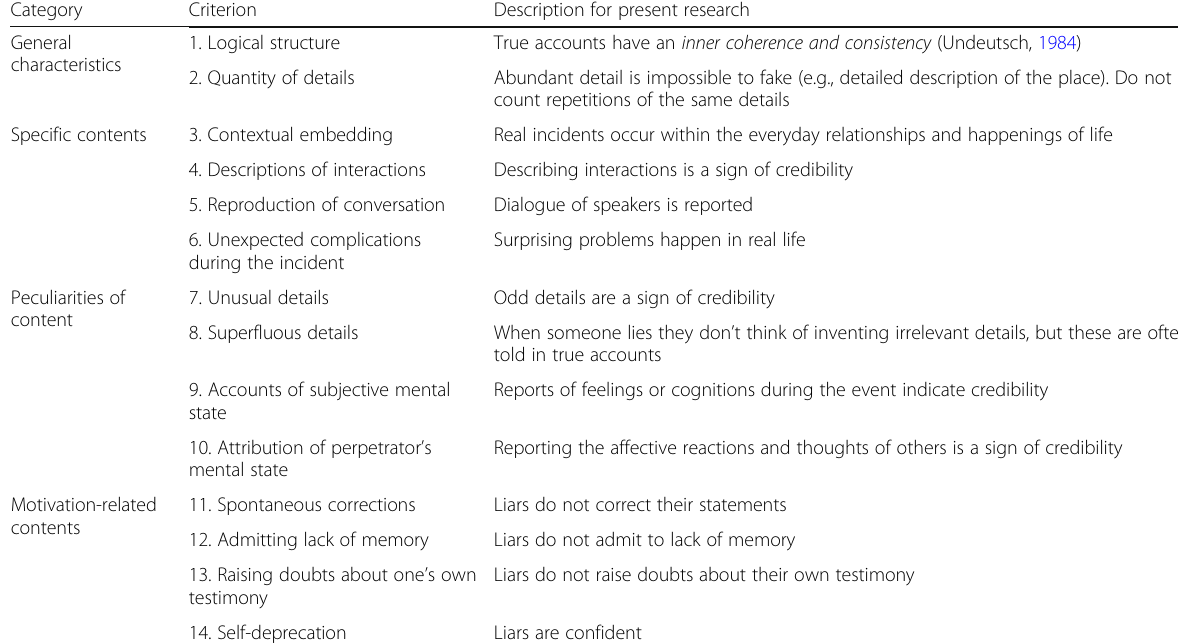
Table 1 Content criteria for statement analysis (from Steller & Köhnken, 1989) Category Criterion Description for present research General